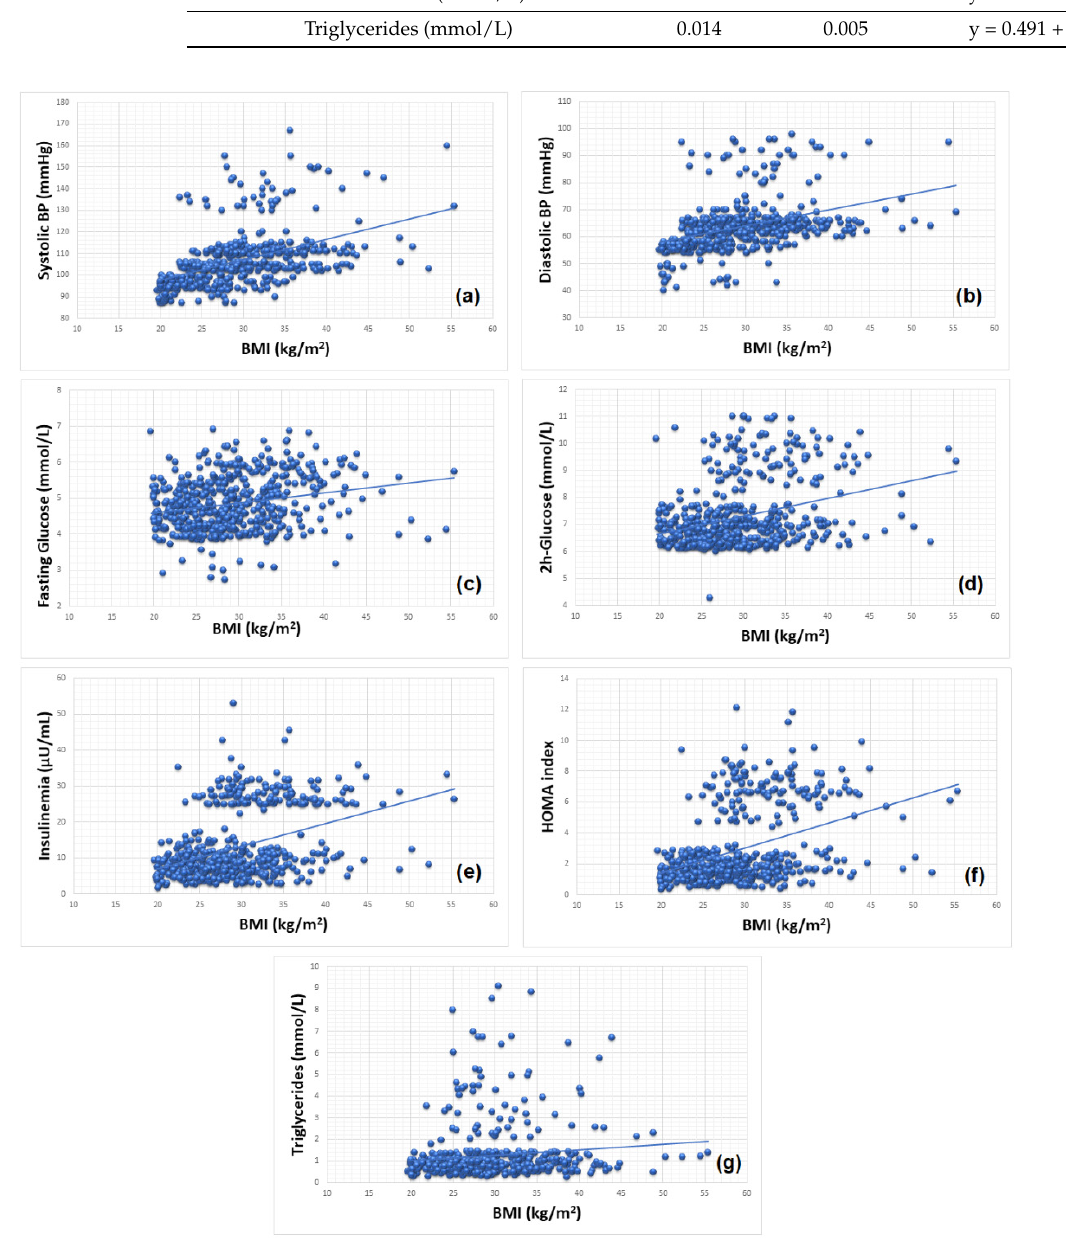
Figure 4. Correlation between BMI and ( a ) systolic blood pressure (BP), ( b ) diastolic BP, ( c ) fasting glucose, ( d ) 2 h glucose, ( e ) insulinemia, ( f ) HOMA index and ( g ) triglycerides.